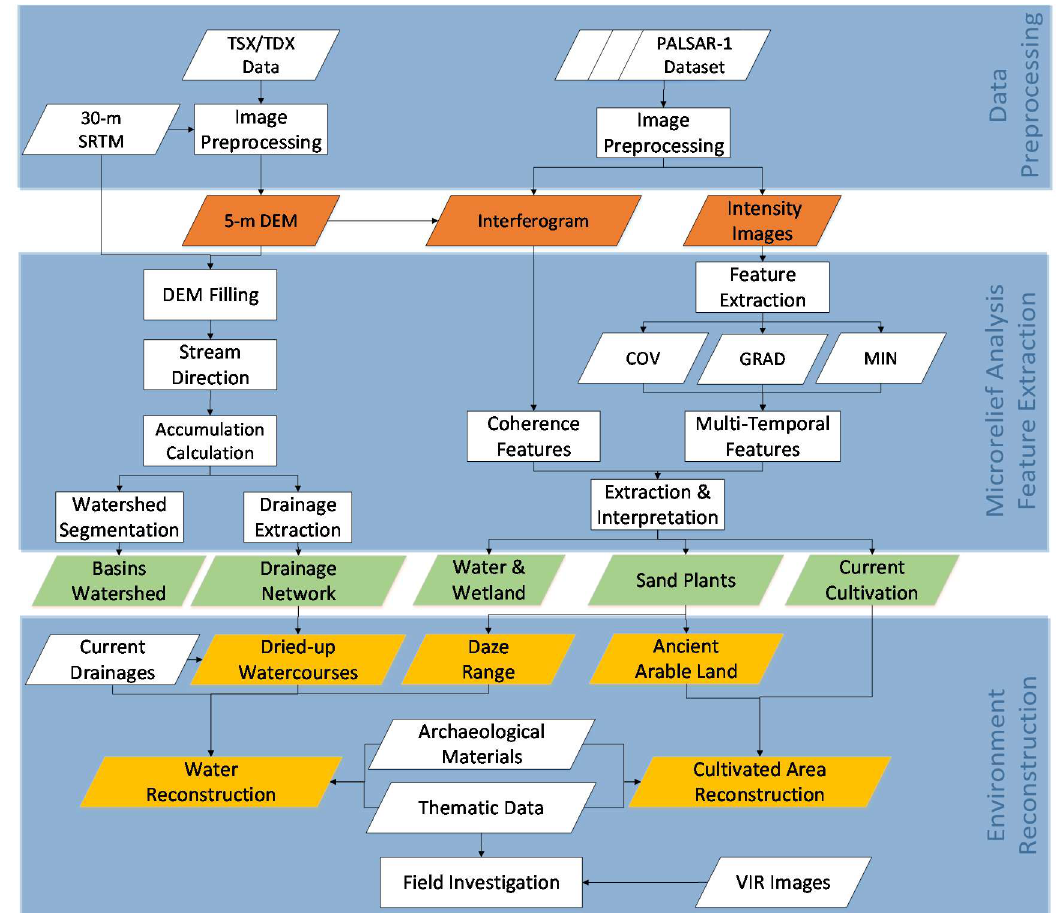
Figure 3. Flowchart of the three main steps: data preprocessing, microrelief analysis and feature extraction, and reconstruction of the water cultivation paleoenvironment. The orange parallelograms, green parallelograms and yellow parallelograms represent the outcomes of the three processing steps.